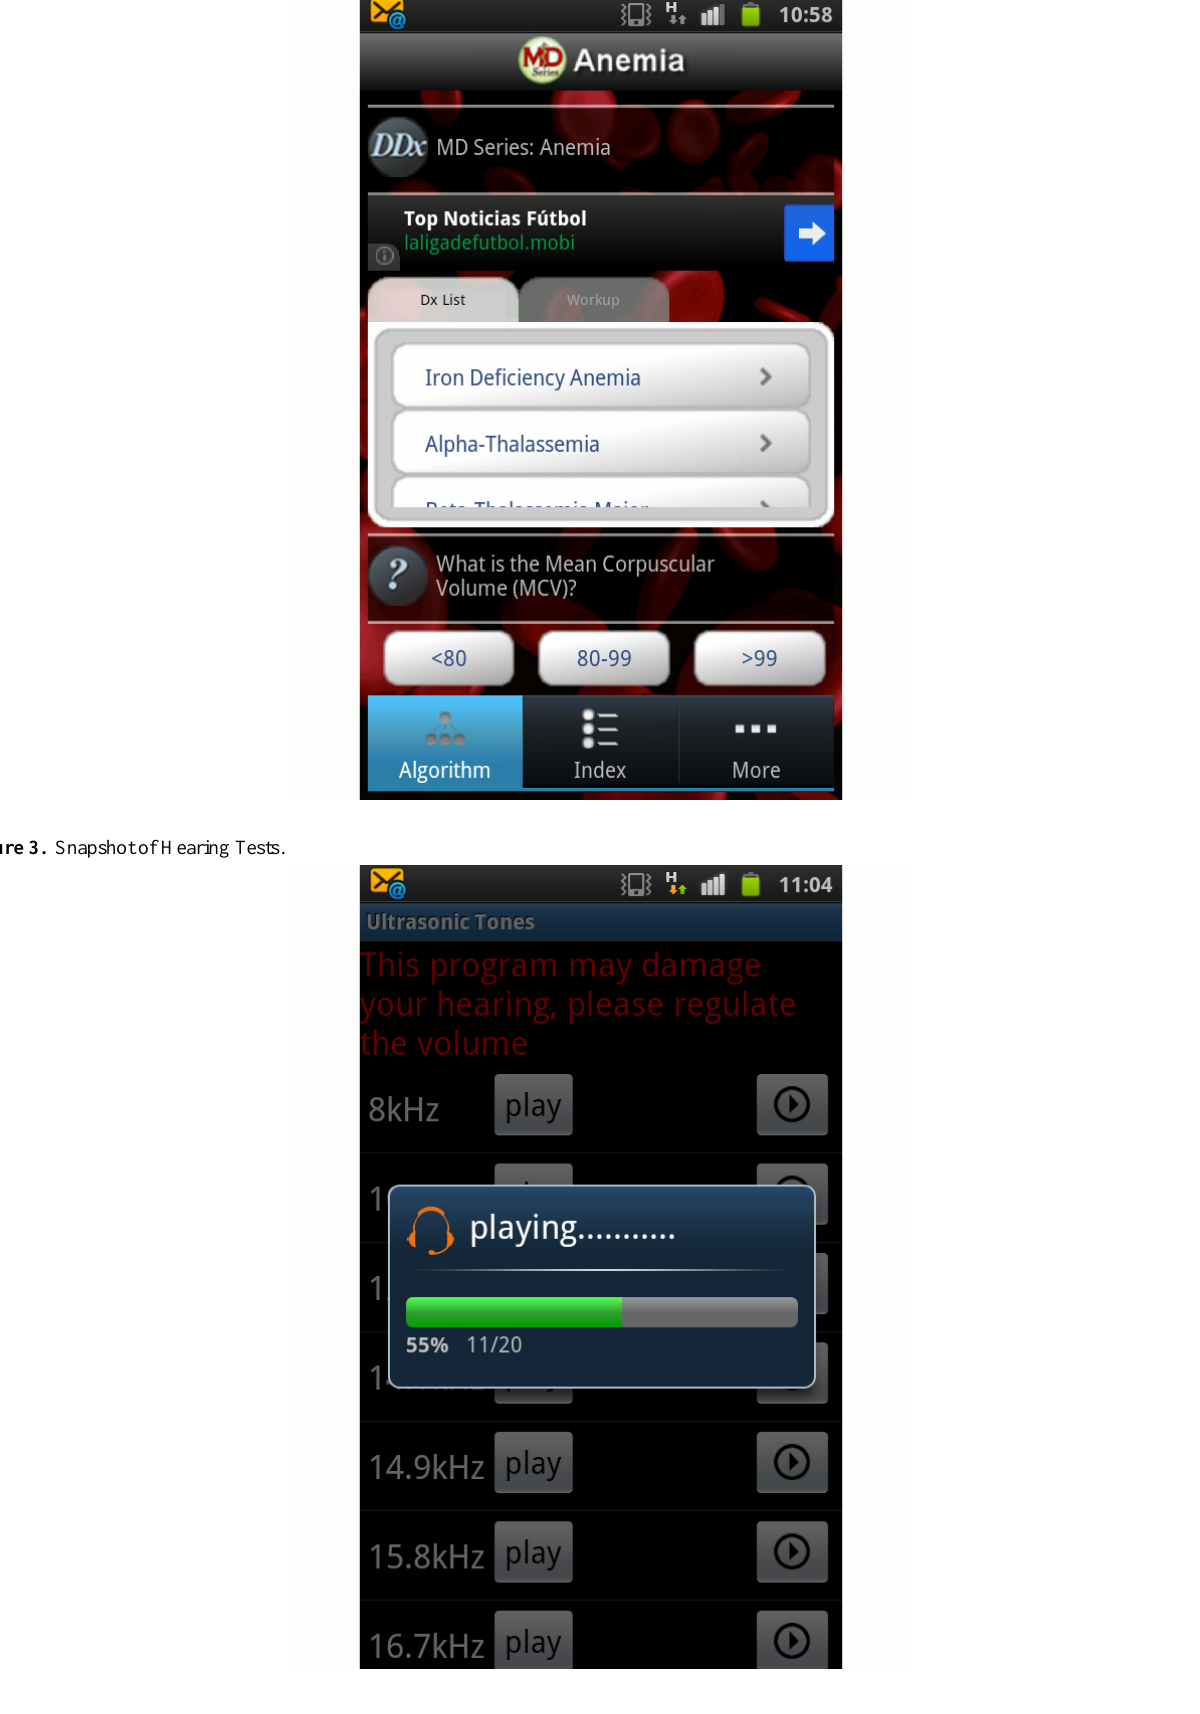
Figure 2. Snapshot of MD Series: Anemia–Free.